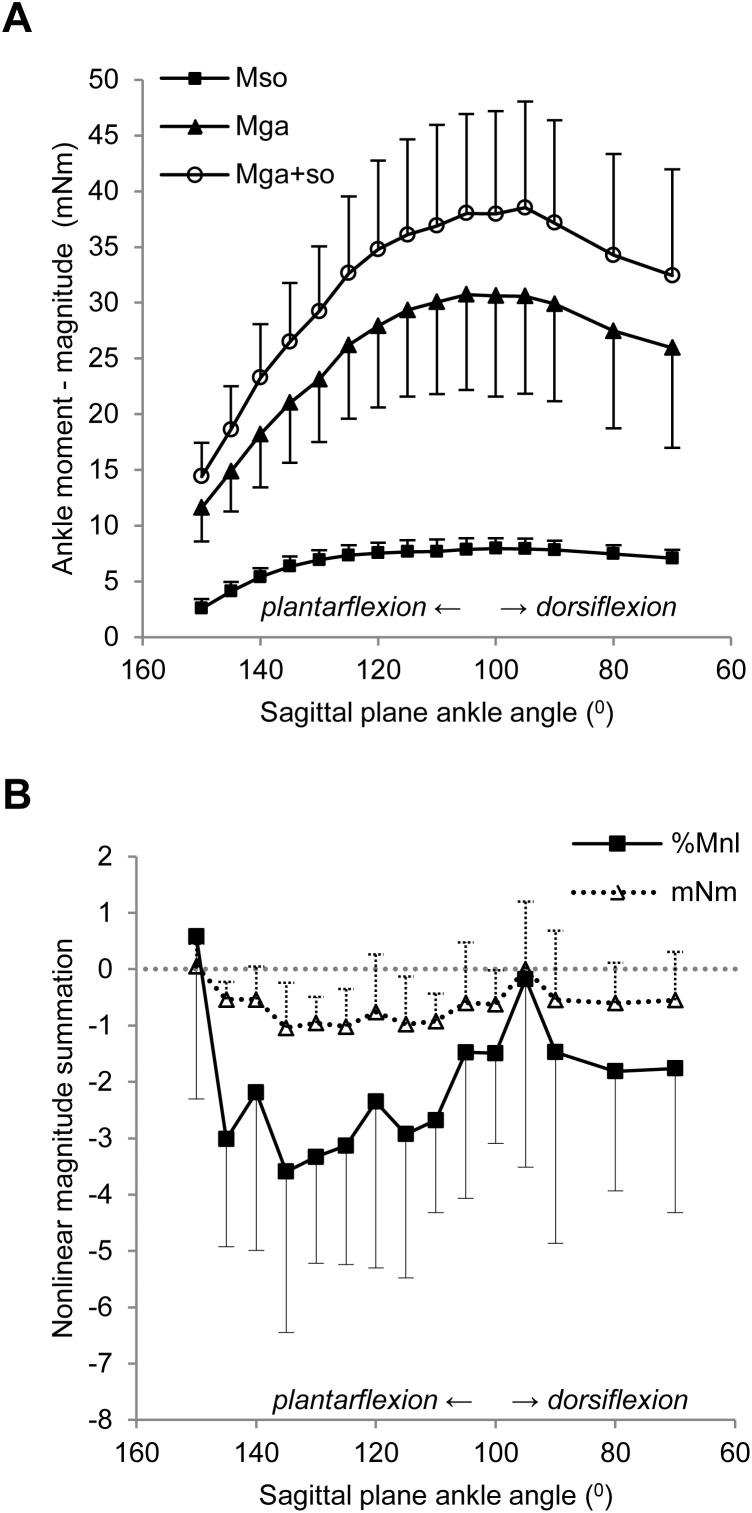
Effects of ankle dorsi-flexion on nonlinear moment summation of SO and GA muscles.A) Active 3D moment exerted by simultaneous excitation of GA+SO (○), and by individual excitation of SO (▪) and GA (▴) plotted as a function of sagittal plane ankle angle. Knee angle was kept constant at 90°. B) Effect of sagittal plane ankle angle on nonlinear magnitude summation, both in mNm (Mnl) and relative to the mathematical sum of the ankle moments exerted by individual SO and GA muscles (%Mnl). Negative values indicate a lower ankle moment exerted on simultaneous excitation of GA+SO muscles than the mathematical sum of the ankle moments exerted by individual SO and GA muscles. No effects of the sagittal plane ankle angle on relative nonlinear magnitude summation (p = 0.138) was found after excluding the data at 150° from the analysis. Averaged across all ankle angles except 150°, the relative nonlinear magnitude summation was significantly different from zero (p<0.001). Means ± s.d. are shown (n = 10).